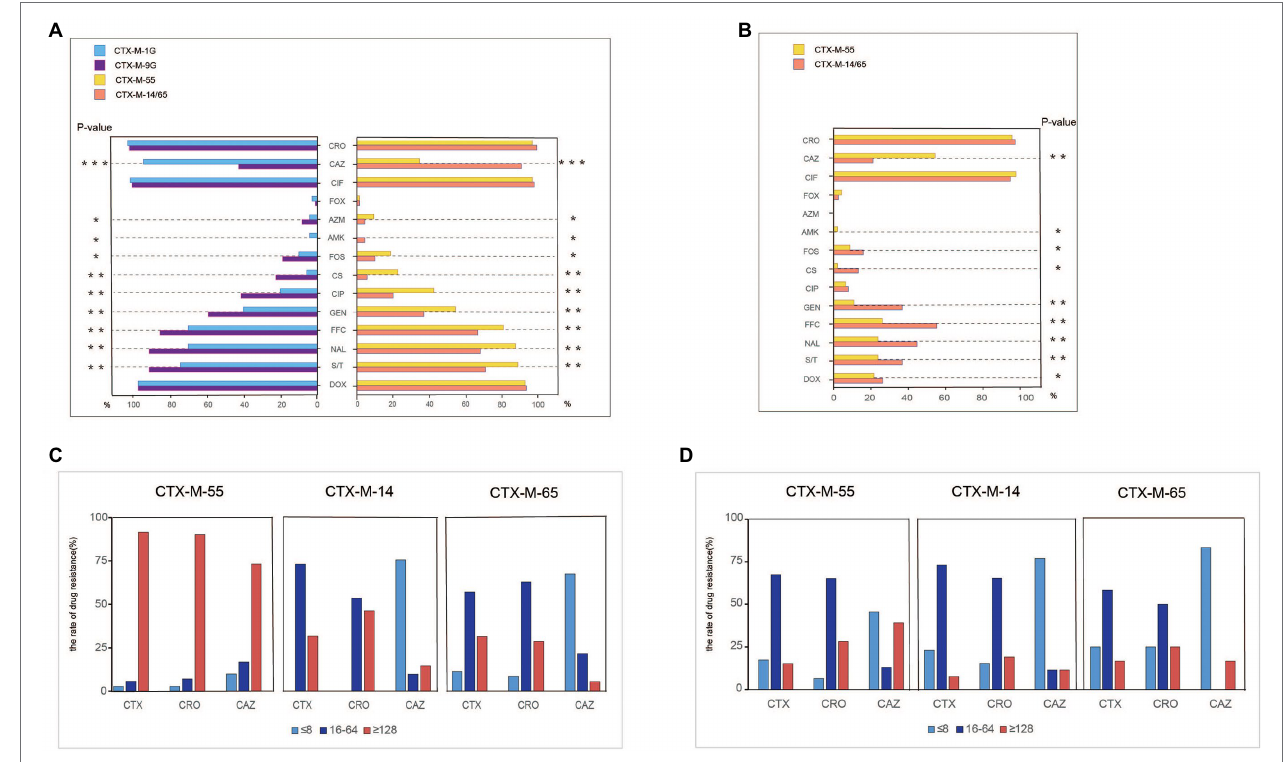
FIGURE 2 | Antimicrobial-resistant phenotypes analysis of bla CTX-M -positive S. Typhimurium isolates and transconjugants isolates. (A) Antimicrobial-resistant phenotypes analysis of bla CTX-M-1G/9G/55/14/65 -positive S. Typhimurium isolates. (B) Antimicrobial-resistant phenotypes analysis of bla CTX-M-1G/9G/55/14/65 -positive S. Typhimurium’ transconjugants. (C) Anslysis of resistant to CTX, CRO, and CAZ in bla CTX-M-55/14/65 -positive S. Typhimurium isolates. (D) Anslysis of resistant to CTX, CRO, and CAZ in bla CTX-M-55/14/65 S. Typhimurium’ transconjugants. CTX, cefotaxime; CRO, ceftriaxone; CAZ, ceftazidime; CIF, ceftiofur; FOX, cefoxitin; AZM, azithromycin; AMK, amikacin; FOS, fosfomycin; CS, polymyxin; CIP, ciprofloxacin; GEN, gentamicin; FFC, florfenicol; NAL, nalidixic acid; S/T, sulfamethoxazole/ trimethoprium; and DOX, doxycycline. * means statistically different ( p < 0.05), ** means the difference is more significant ( p < 0.01), *** means the difference is particularly significant ( p <